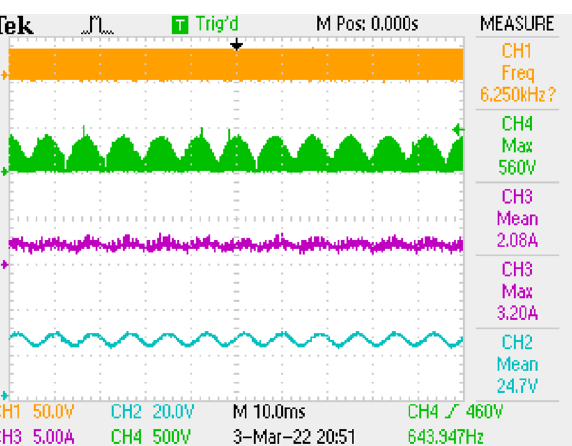
Figure 15. Measurements by LC with parallel damping DM filter, PWM, voltage of switch, current–voltage of